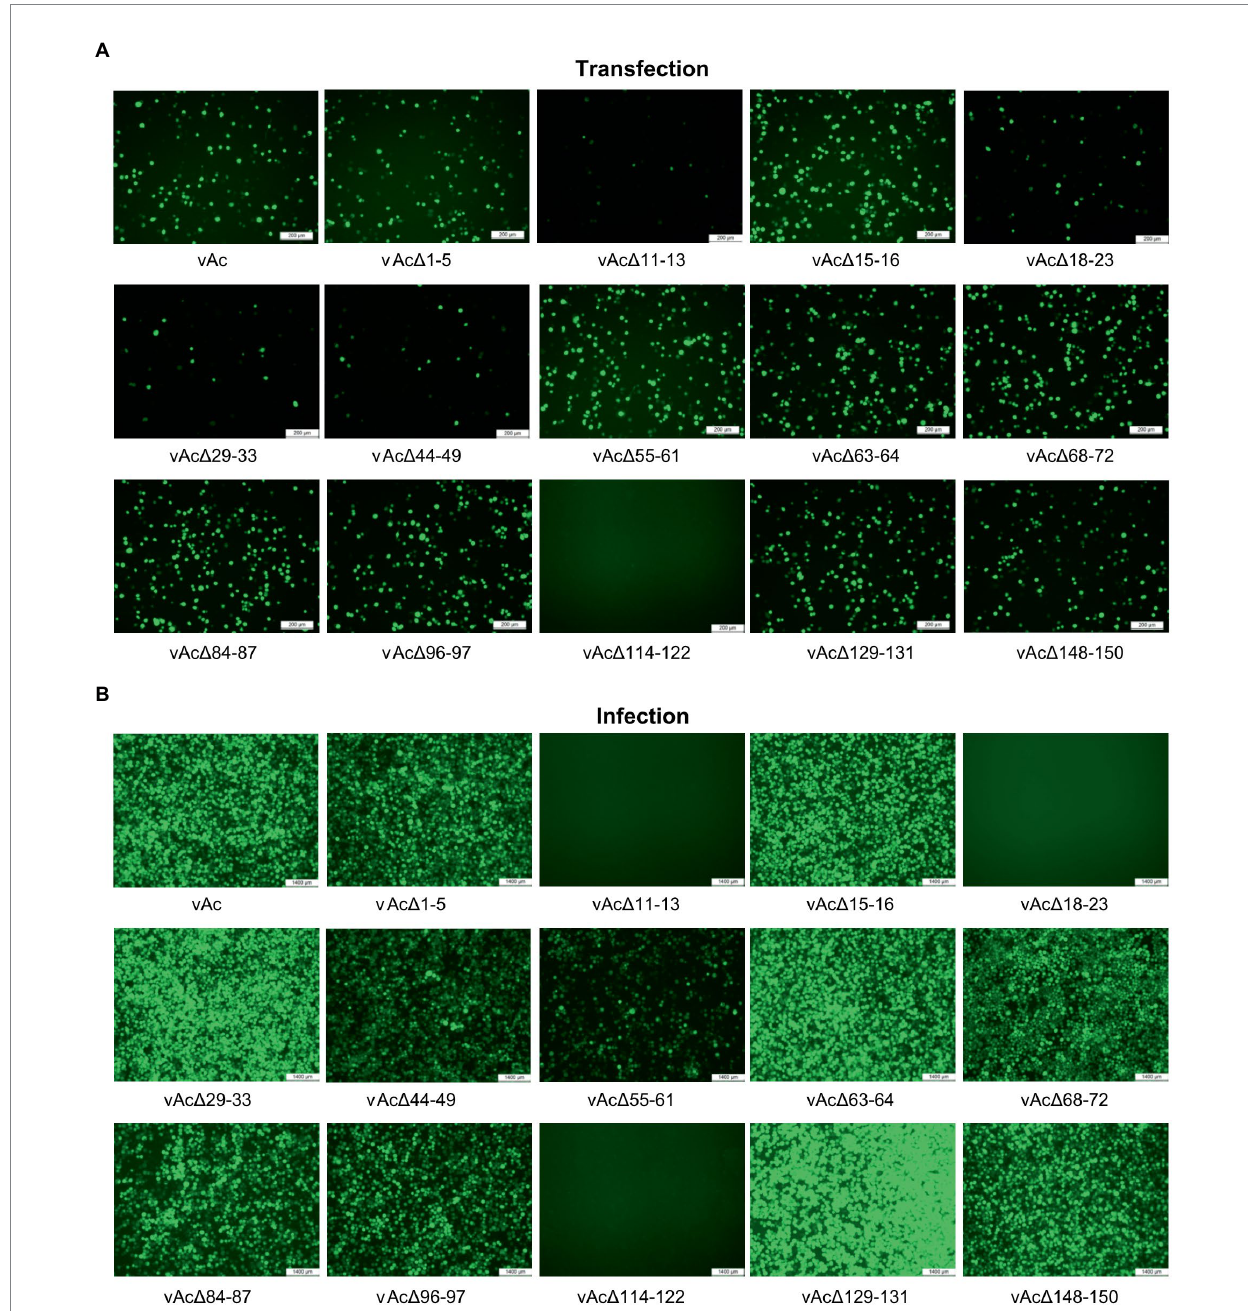
FIGURE 2 Characterization of KO AcMNPV expressing GFP by fluorescence microscopy. (A) The influence of the DNA fragment deletion on GFP expression after transfection. Sf 9 cells were co-transfected with the KO bacmids and pTriEx-GFP, and the images were taken at 5 days post transfection (dpt). Bar, 200 μ m. (B) The cells infected with the KO AcMNPV. The cell culture supernatants were harvested at 5 dpt and used to infect Sf 9 cells, and the images were captured at 5 days post infection (dpi). Bar, 200 μ